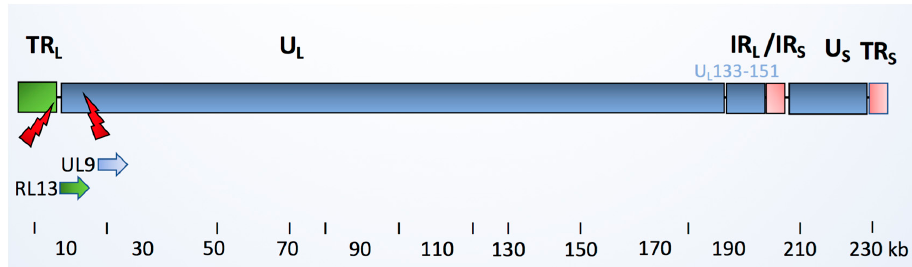
Figure 1. Schematic picture of the HCMV clinical isolate. The HCMV viral genome consists of linear double stranded DNA, ranging from 220 to 240 kB in length. The genome is comprised of unique long (UL) and a unique short (US) regions, which are flanked by inverted open reading frame (ORF) repeats, named terminal repeat long (TRL), internal repeat long (IRL), internal repeat short (IRS), and terminal repeat short (TRS) regions. The latency regions consisting of 19 ORFs (denoted UL133-151) are highlighted. They are present in the low-passage HCMV clinical strains, but are missing in the HCMV laboratory strain AD169. The HCMV-DB clinical strain is reported to share 99% genomic similarity to Toledo and JP clinical strains, but is mutated in RL13 and UL9 genes [11]. A previous functional annotation of these protein products showed that UL9 encodes for a membrane glycoprotein that is involved in viral growth suppression, whereas RL13 encodes for a 60S ribosomal protein. RL13a has a role in epithelial tropism.